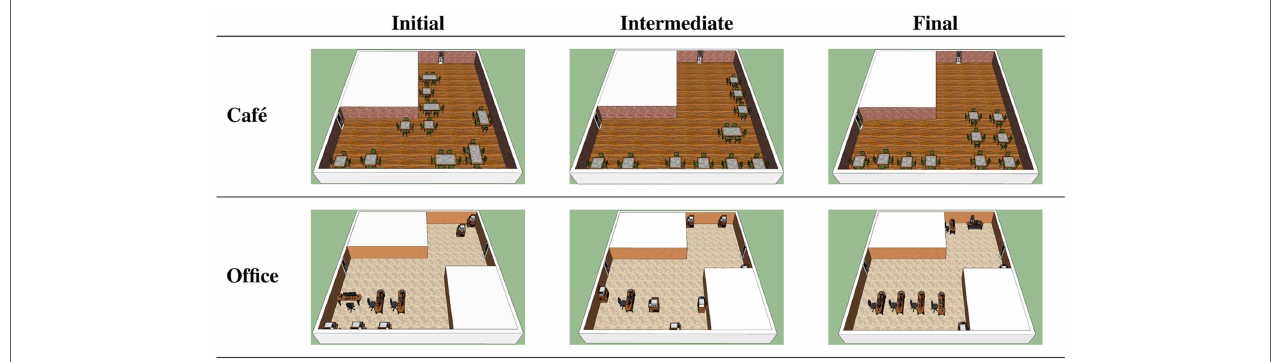
FIGURE 6 | Two use cases of our system. The images are 3D renderings of configurations recommended by our system when interacting with users whose goal is to furnish a cafe (top) and an office (bottom). Horizontally, the figures show different stages of the elicitation process. In the cafe, 1 × 1 and 1 × 2 tables are seen as dining tables of different sizes, whereas in the office 1 × 2 tables represent desks while 1 × 1 tables contain utilities such as printers. Best viewed in